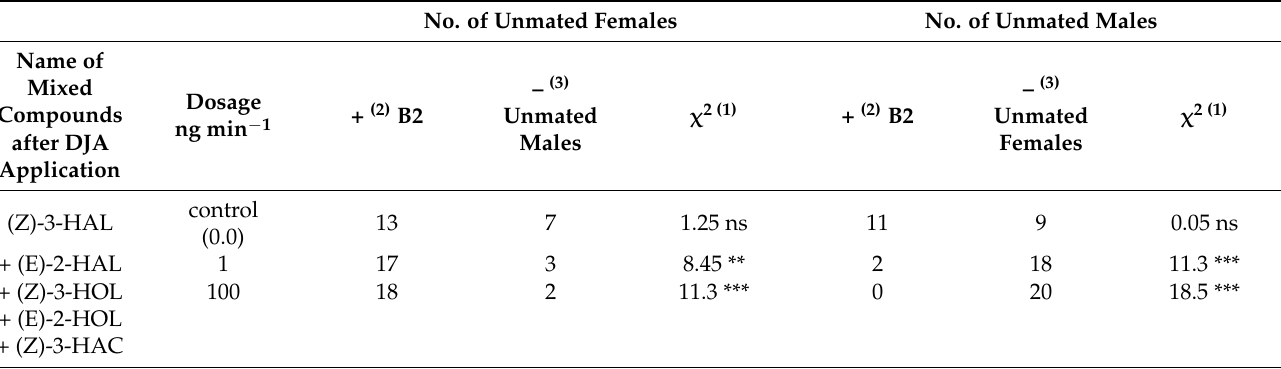
Table 7. The effect of a synthetic blend of three GLVs (blend B2) on unmated beetles and on the number of A. miniatum adult females and males choosing to enter a Y-tube arm containing the blend odor or the control Y-tube arm containing purified, humidified air and hexane solvent (no odor). Only concentrations working as attractants (see Tables 1 and 2) were